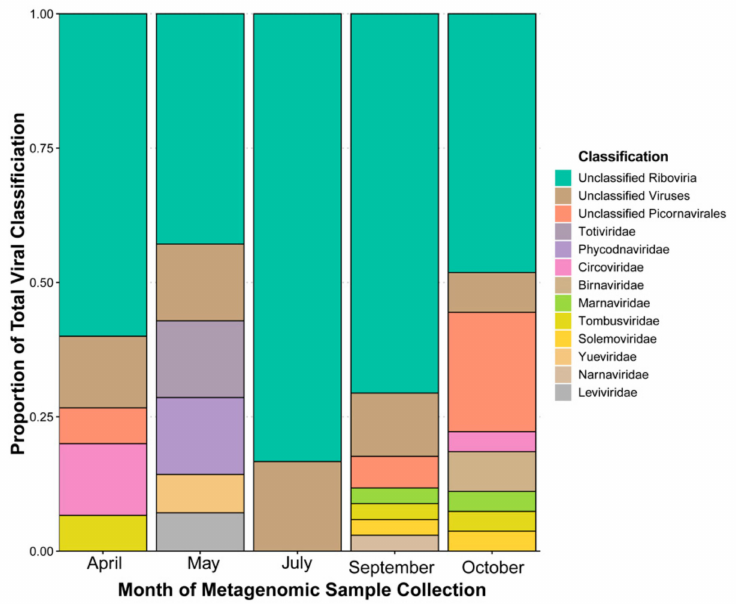
Figure 1. Proportion of contig viral classification (to family when possible) by each metagenomic sample month in 2018. Classifications are based on previously described database alignments by Blast. Only results of the Domain viruses are included. Total number of viral classifications by month were 15 for April, 14 for May, 18 for July, 34 for September, 27 for